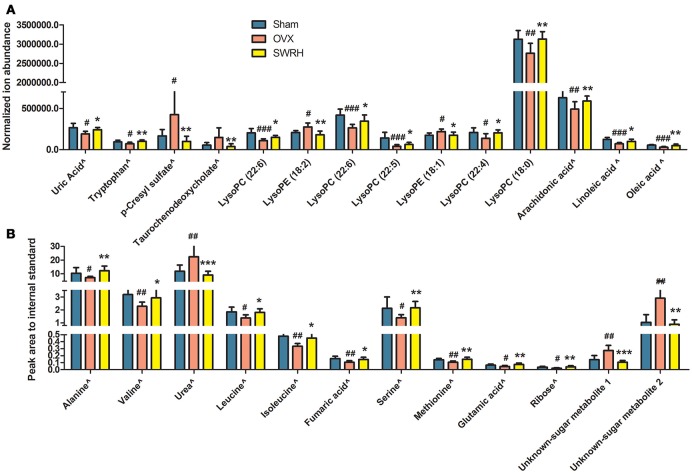
Relative quantities of endogenous metabolites significantly changed after SWRH treatment. Bars represent the mean relative levels and standard deviations. (A) UPLC-MS metabolites; (B) GC-MS metabolites. ∧Identified with authentic standards. #P < 0.05, ##P < 0.01, ###P < 0.001 OVX vs. Sham; *P < 0.05, **P < 0.01, ***P < 0.001 SWRH vs. OVX.